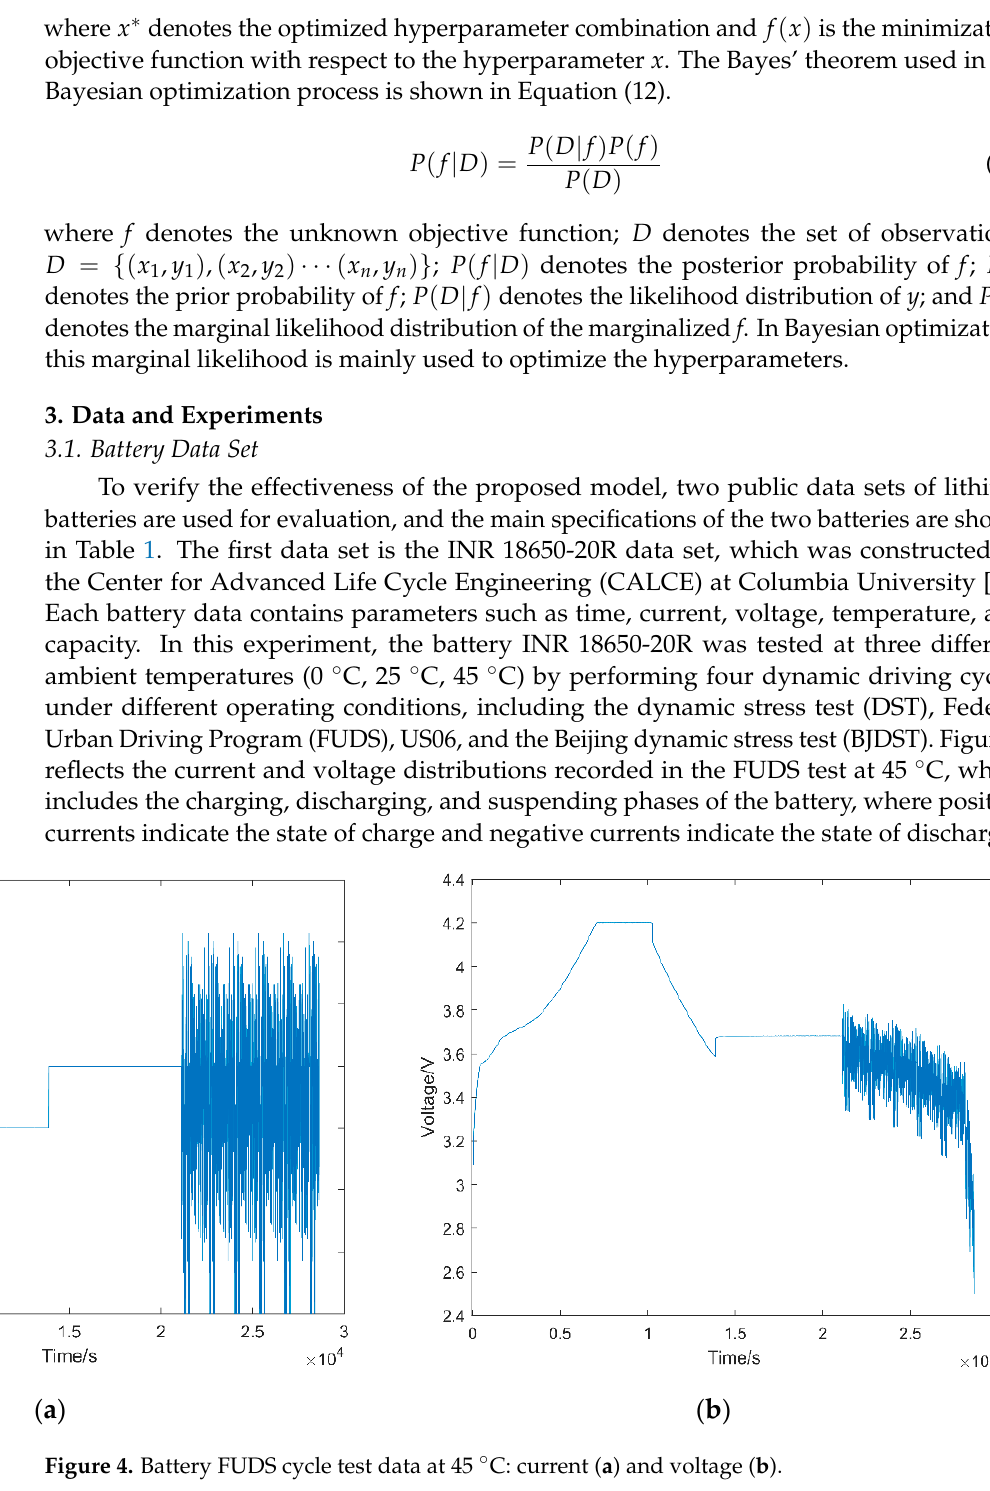
Figure 4. Battery FUDS cycle test data at 45 °C: current ( a ) and voltage ( b ).